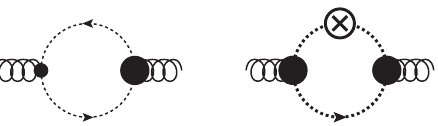
Figure 1: Ghost loops in the gluon propagator DSE (left), [ 28 ] and FRG (right), [ 18 ] . Internal dashed (wiggly) lines represent fully dressed ghost (gluon) propagators. Thin (thick) blobs depict undressed (dressed) vertices. The crossed circle in the FRG diagram denotes the regulator insertion. The massless ghost propagator causes these diagrams to yield logarithms as given in (26). The dressing of ghost-gluon vertex can- not change this qualitative behavior since it is constant in the infrared, see Figure